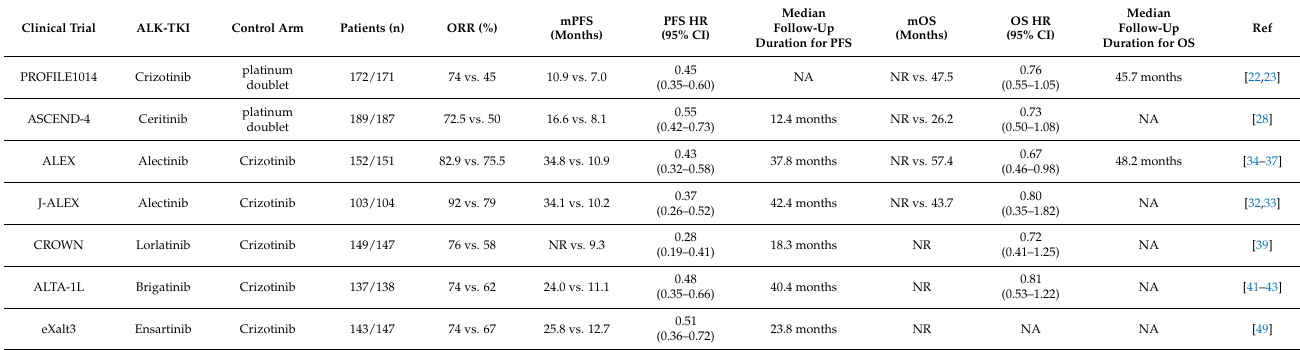
Table 1. Clinical trials as first-line treatment.